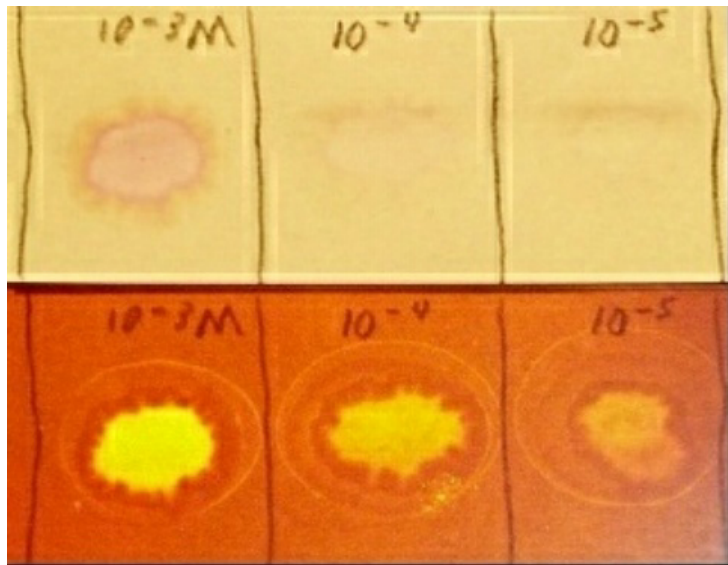
FIGURE 1. Sensitivity comparison for RDX by colorimetry (top) and photoluminescence (bottom) using ETK Plus . See text. Chromatography paper strip width = 3.8